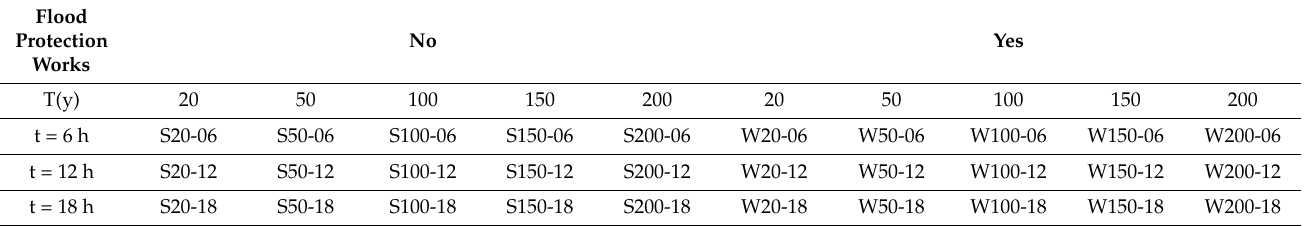
Table 1. Scenarios of